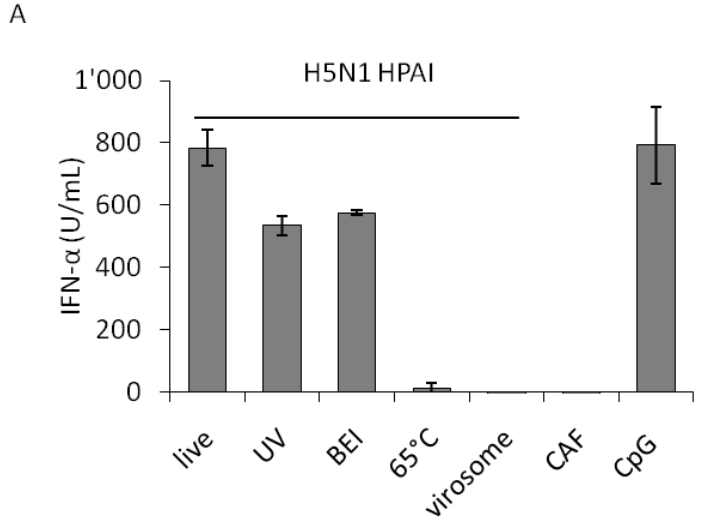
Figure 1. IFN-  responses of plasmacytoid dendritic cells (pDC): impact of virus inactivation, as well as virus-dose dependency using either HAU or TCID influenza A virus (IAV). Porcine pDC were enriched from fresh blood, plated and stimulated. IFN-α in the supernatant was quantified by ELISA after 24 h. ( A ) pDC were stimulated with live, UV-, 2-bromoethylamine hydrobromide (BEI)- or 65 °C heat- inactivated H5N1 virus (H5N1 TT05, see Table 1) or with H5N1-derived virosomes at a dose of 40 HAU. Allantoic fluid (CAF) or CpG (10  g) were used as controls. Error bars represent standard deviations of triplicate ELISA samples. ( B and C ) pDC were stimulated with a pair of HP- and LPAIV H7N1 (H7N1 TI99 and OI00, see Table 1) at various doses. Error bars represent standard deviations of triplicate